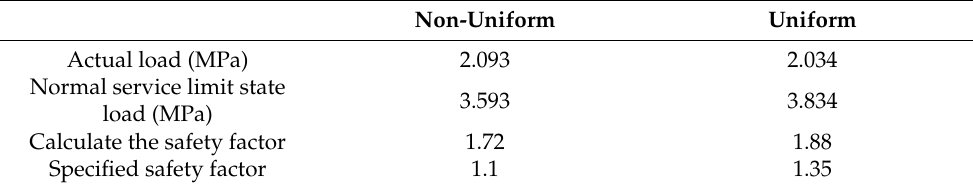
Figure 23. S1ZK0 + 660 m lining damage diagram. ( a ) Uniform pressure (step 15-2); ( b ) Non-uniform pressure (step 18-1). Table 5. S1ZK0 + 660 m section lining safety factor calculation value, according to Method 2.